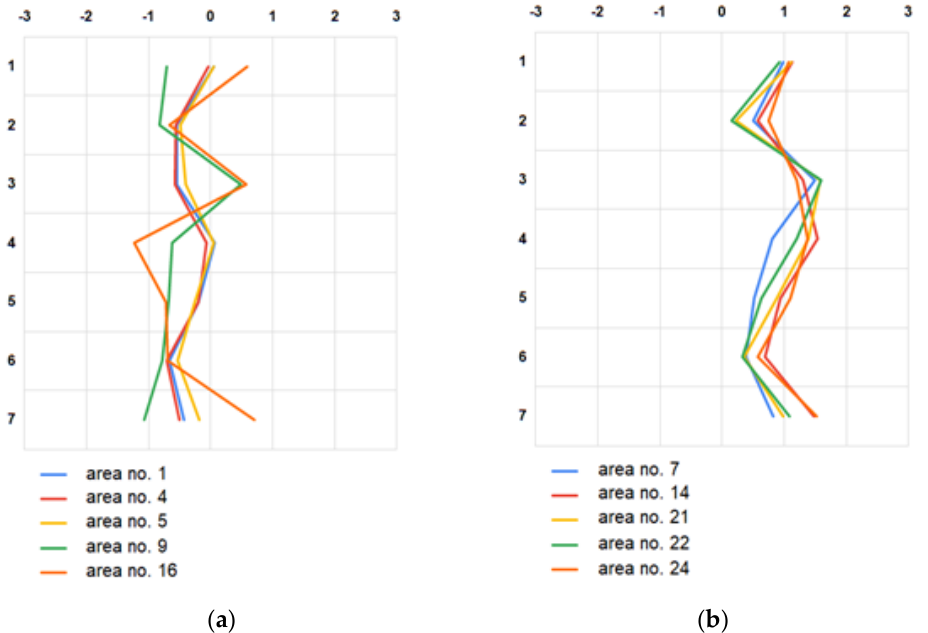
Figure 7. Semantic profiles of the 5 worst ( a ) and best ( b ) rated research areas.